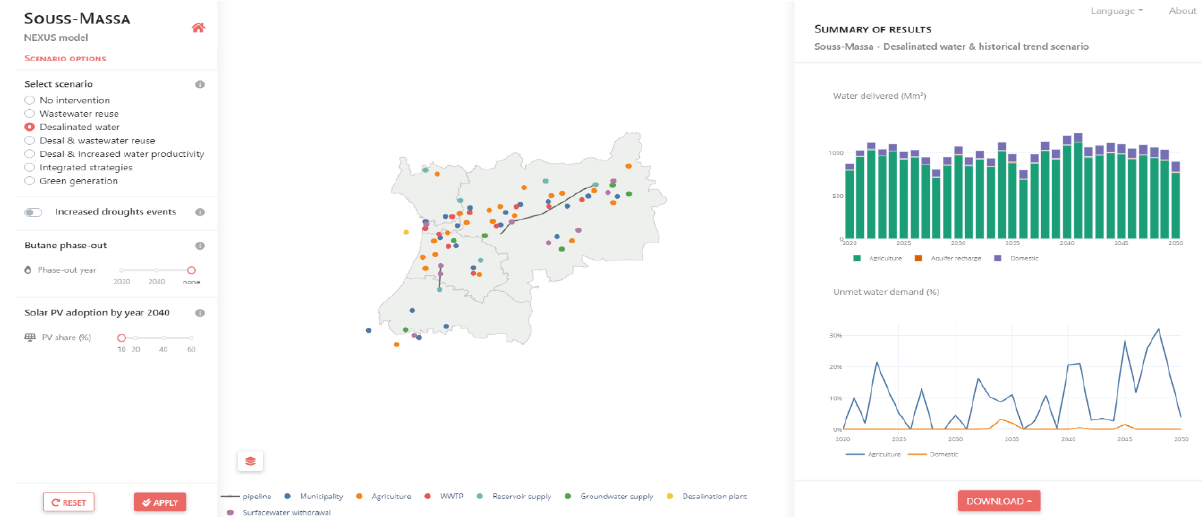
Figure 5 The Souss-Massa online WEF Nexus scenario-based modeling platform (Source: Souss-Massa nexus